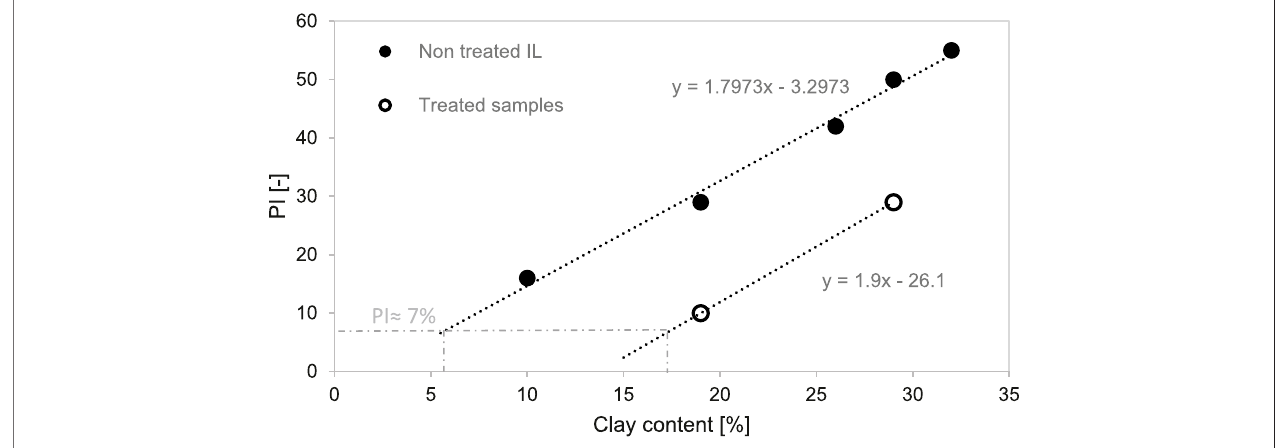
FIGURE6 | Activity plotfor the natural samples tested upon IL and for the treated samples. The natural samplespresented here have the same composition ofthe OM because they originate from the same mother sample.